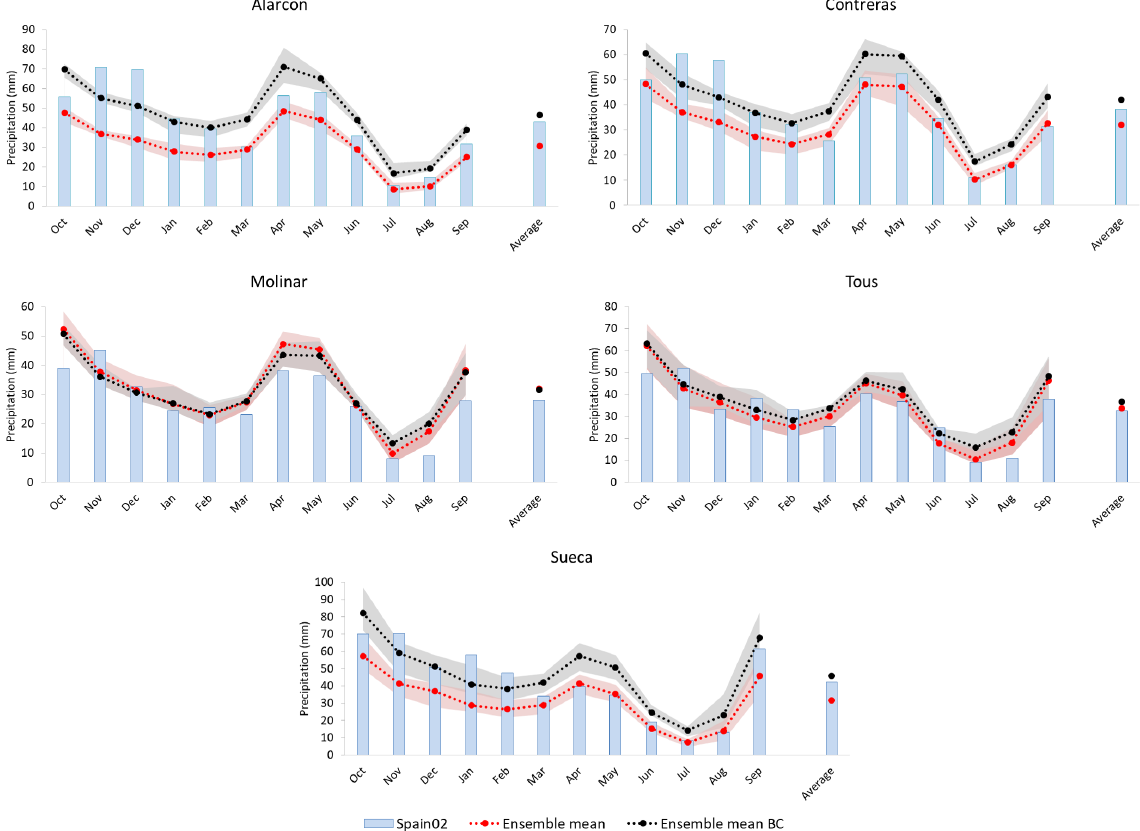
Figure 4. Average monthly and yearly bias-corrected precipitation (ensemble mean BC) compared to the non-corrected precipitation (ensem- ble mean) and the historical data (Spain02 data) in the reference period 1980–2000, where the shaded areas represent the entire ensemble. Table 2. HBV-JRB model performance depending on simulated data and their PBIAS and NSE values based on the classification of the performance ratings recommended by Moriasi et al. (2007) for monthly time steps of streamflows. VG is a very good performance, G is good, S is satisfactory, and U is unsatisfactory. Alarcon Contreras Molinar Tous Sueca HBV-JRB